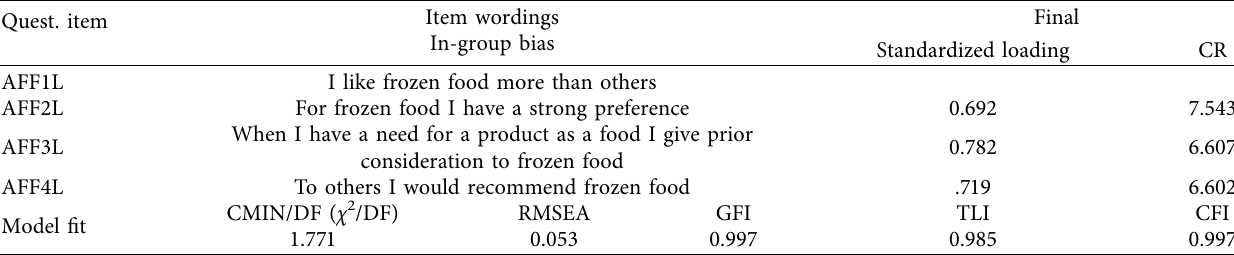
Table 6: Model fit summary (confirmatory factor analysis of attitude toward fast food). Quest.